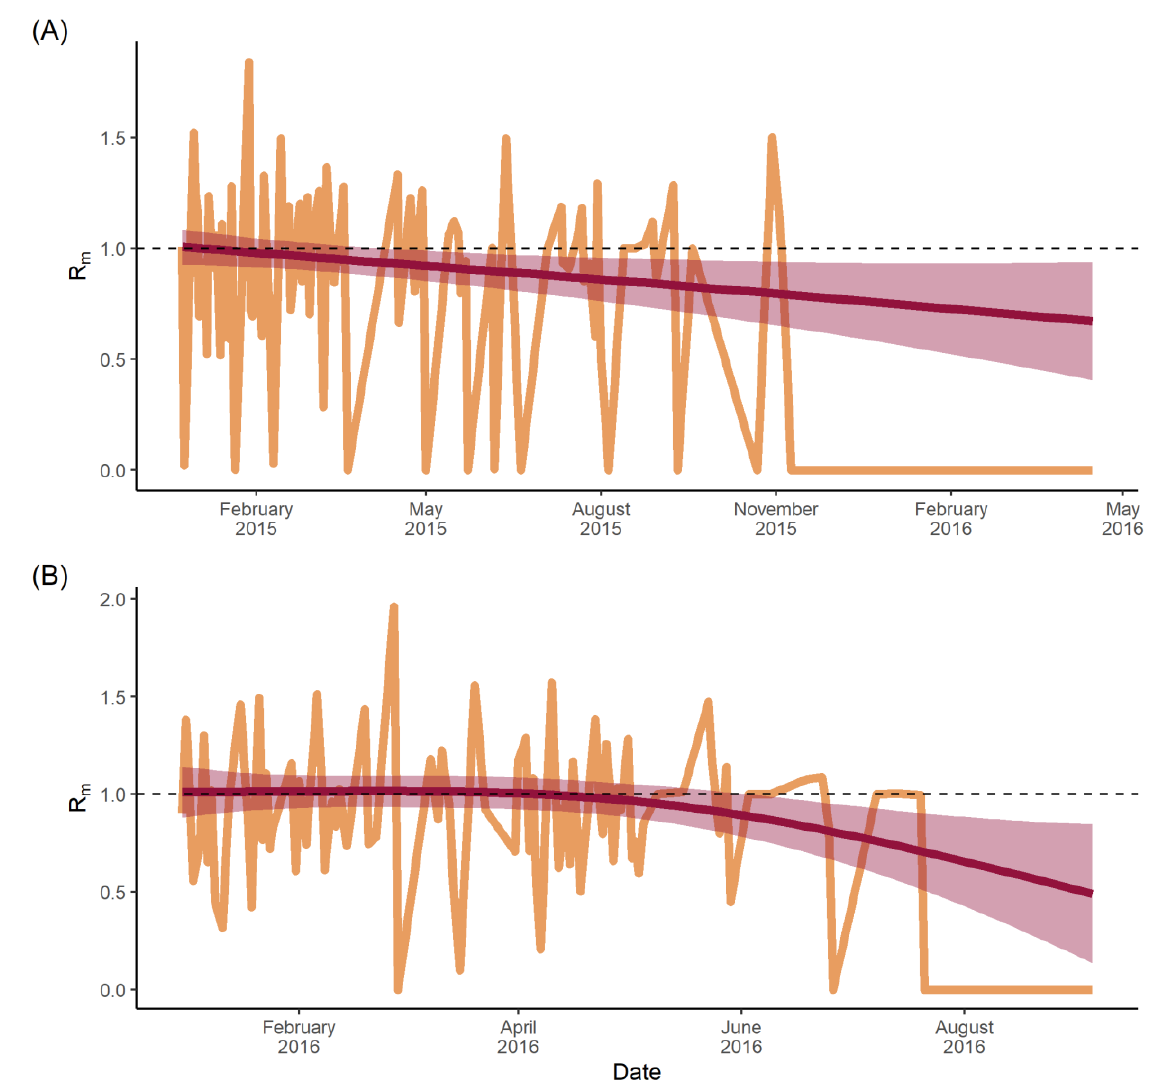
Figure 6. Municipal-specific, time-varying reproduction numbers: ( A ) total dengue cases; ( B ) Zika cases. R m is the number of municipalities a given infector municipality is likely to infect. Red line represents the fitted Generalised Additive Model with smoothing splines and the 95% confidence interval seen as a shaded grey area. Dashed line represents an R m = 1.